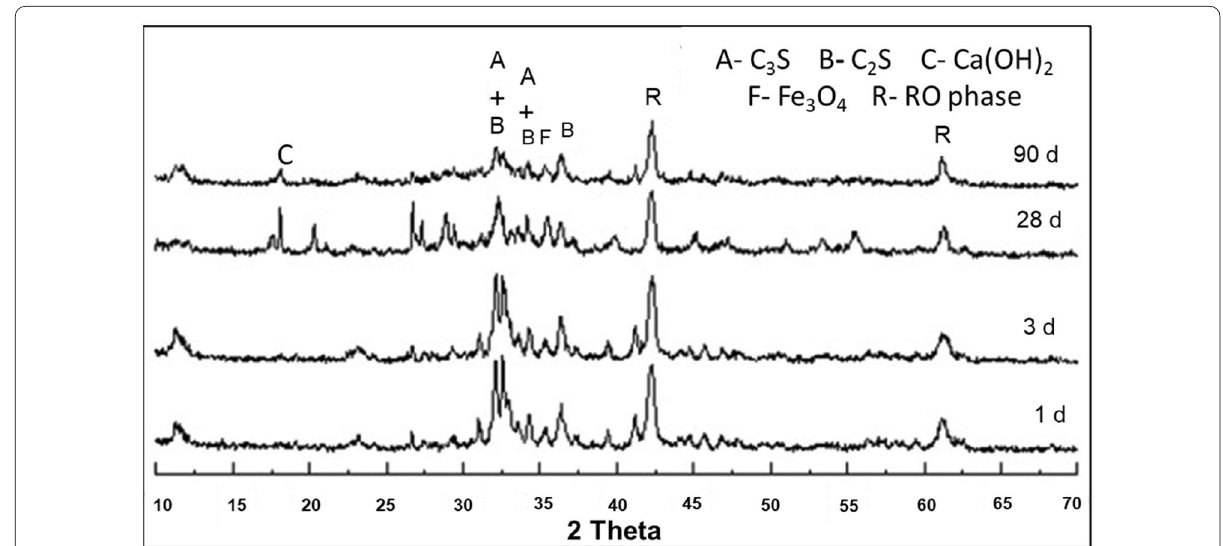
Fig. 8 XRD of LF slag hydrated paste after 1, 2, 28, and 90 days (Wang & Yan,